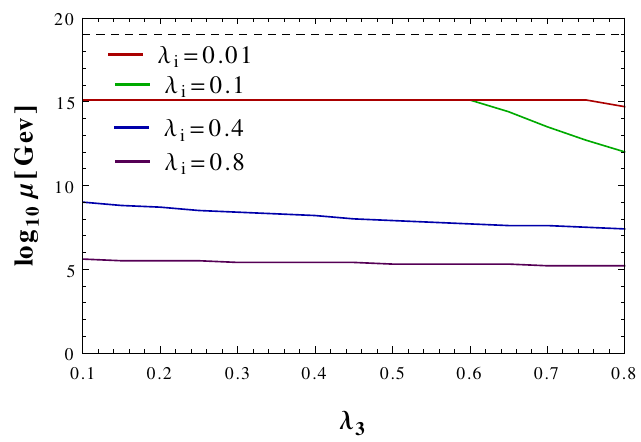
Figure 2 . Bounds on Perturbative scale of the scalar quartic couplings verses (cid:21) 3 at two-loop for Yukawa coupling Y N = 0 : 02, considering three generations of fermionic triplet. Di(cid:11)erent initial values are designated as red, green, blue and purple curves for (cid:21) i = 0 : 01 ; 0 : 1 ; 0 : 4 ; 0 : 8 respectively at the EW